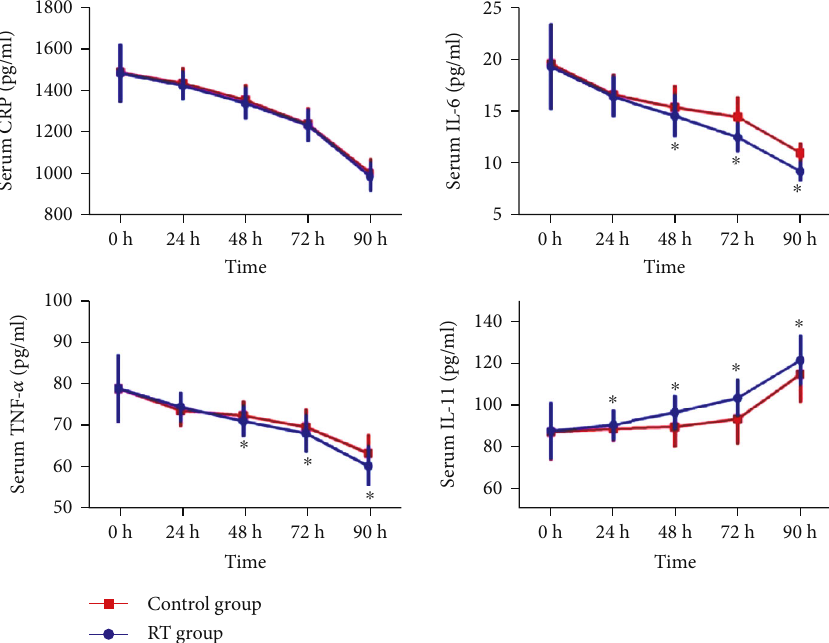
Figure 1: Comparisons of serum IL-11 and other in fl ammatory factors levels between two groups. Data were expressed by mean ± SD . The continuous data were compared using Student ’ s t test between two groups. All data were normally distributed.